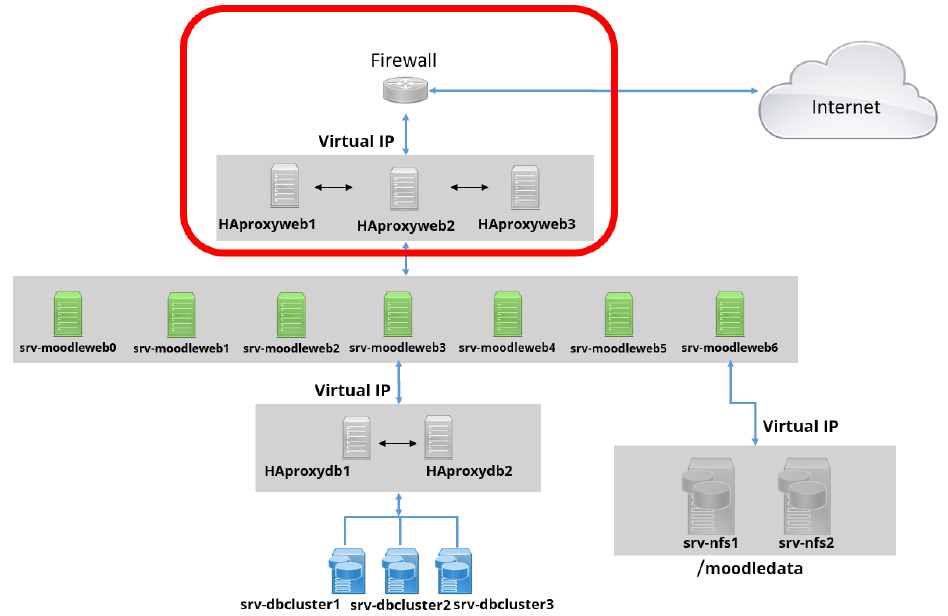
Figure 4. Moodle cluster Infrastructure.